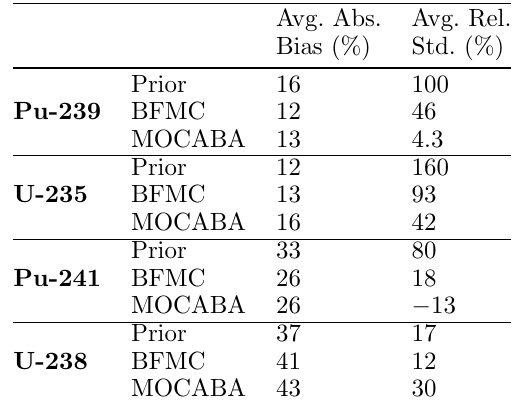
Fig. 10. Relative differences between GEF and JEFF3.3 of the means and standard deviations of Pu-239 independent FYs. Table 3. Comparing GEF independent FYs (prior & posterior) to